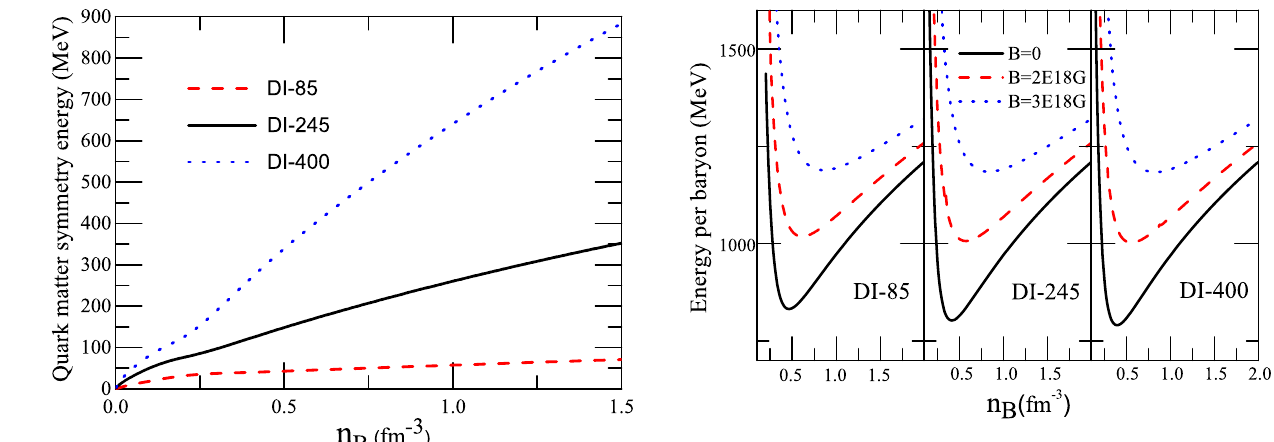
Fig. 2 Energy per baryon number as functions of baryon